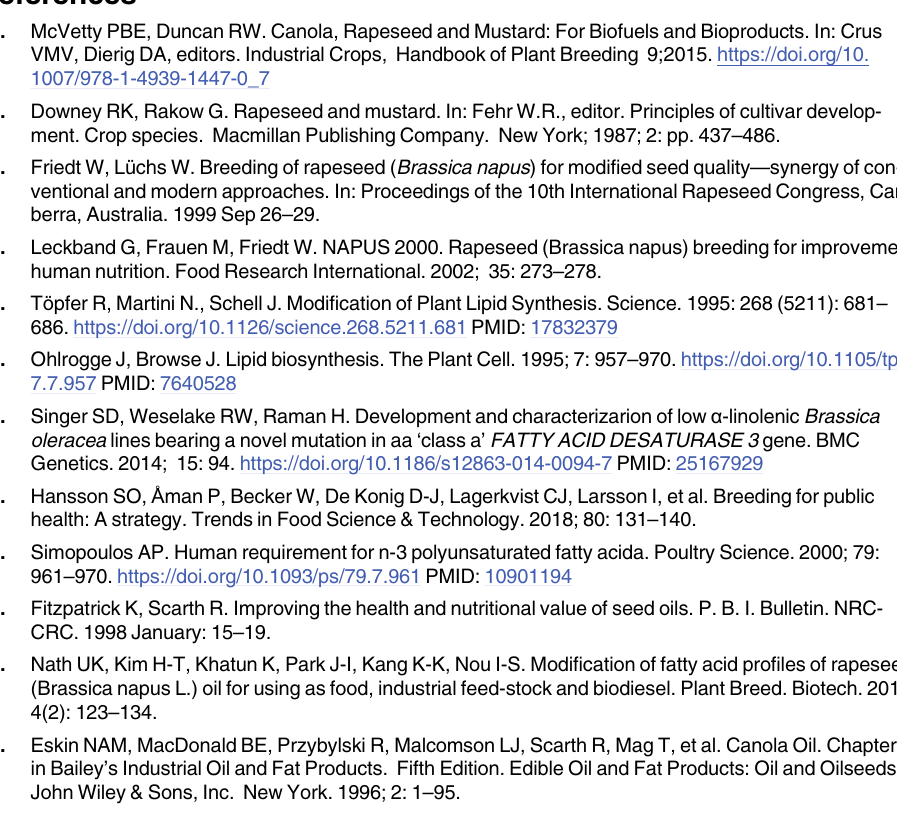
S4 Table. Characteristics of field trials in four